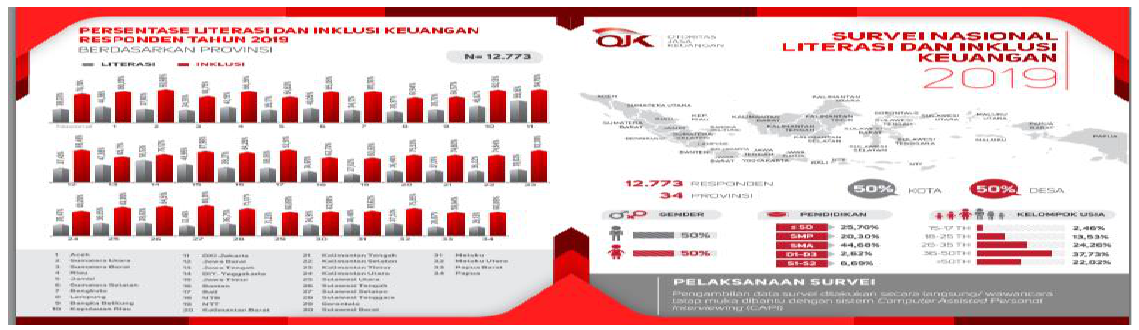
Figure 1. Indonesia's 2019 financial literacy